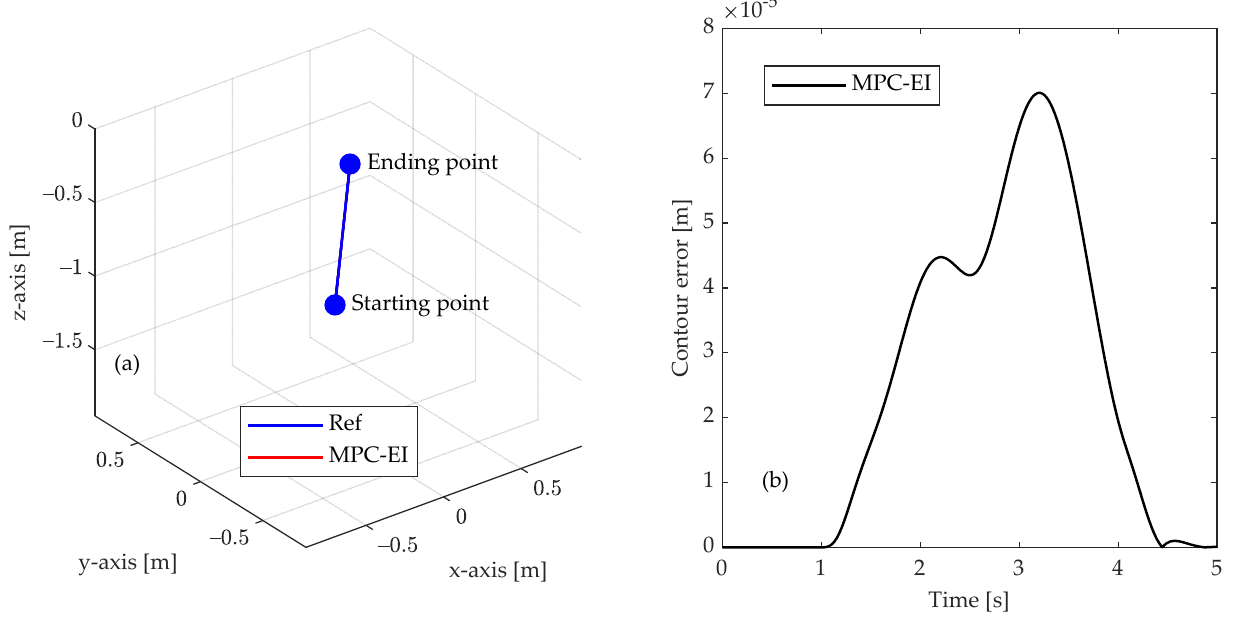
Figure 10. Path tracking response of the straight line: spatial representation ( a ) and its contour error ( b ).